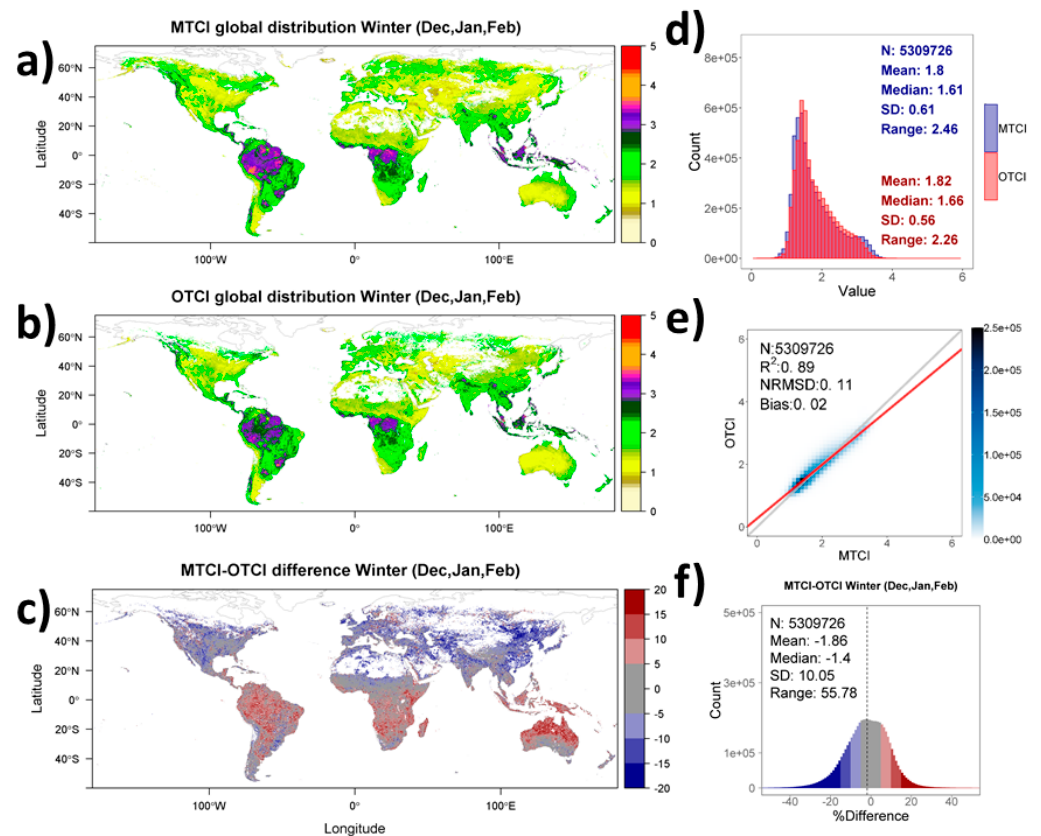
Figure 5. Global composites of the Sentinel-3 OTCI (mean of 2016 to 2019) and Envisat MTCI (mean of 2002 to 2012) for winter—i.e., Dec, Jan, Feb ( a , b )—and spatial distribution of di ff erences ( c ). Index value frequency distribution ( d ), density scatterplot of the agreement between the two products ( e ), and frequency distribution of di ff erences ( f ). For ( c ) and ( f ), di ff erence is expressed in percentage computed as the ratio of per pixel absolute di ff erence to the mean of the two pixels. Blue indicates areas where the Sentinel-3 OTCI is greater than the Envisat MTCI, conversely, red indicates areas where the Envisat MTCI is greater than the Sentinel-3 OTCI. Grey pixels are areas where the di ff erence between the Envisat MTCI and Sentinel-3 OTCI is within ±5%.